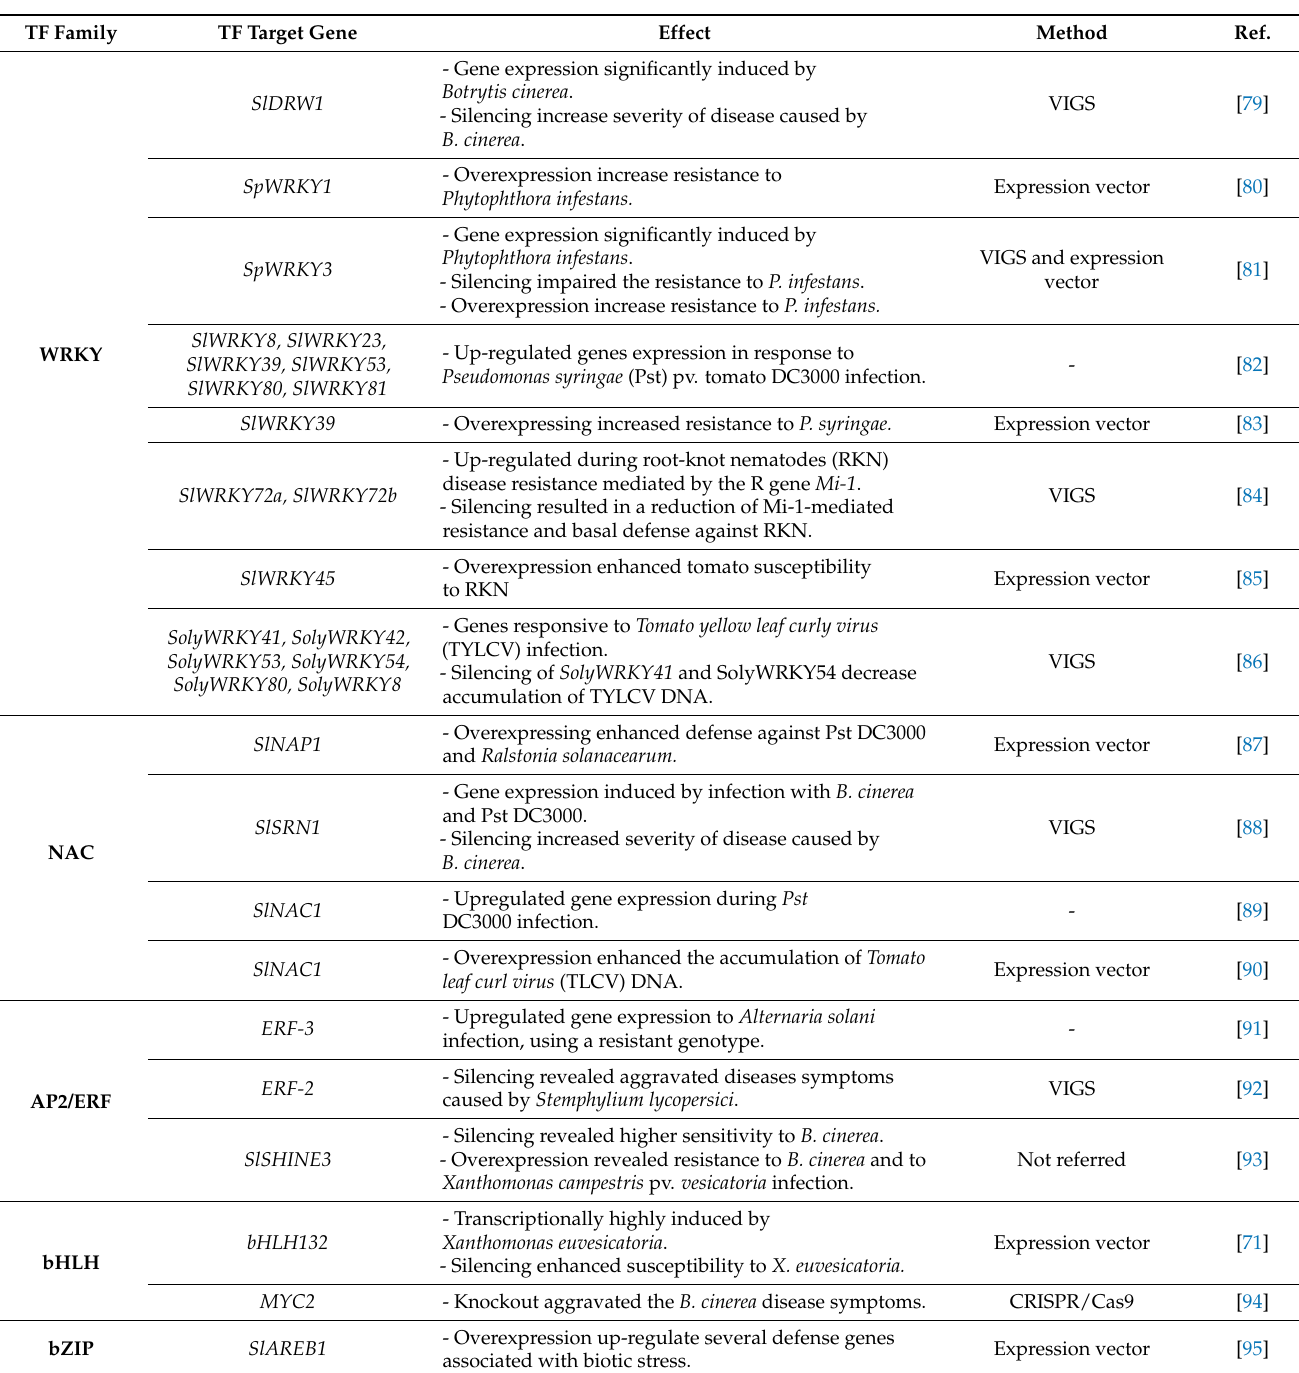
Table 1. Role of transcription factors (TFs) in tomato response to biotic